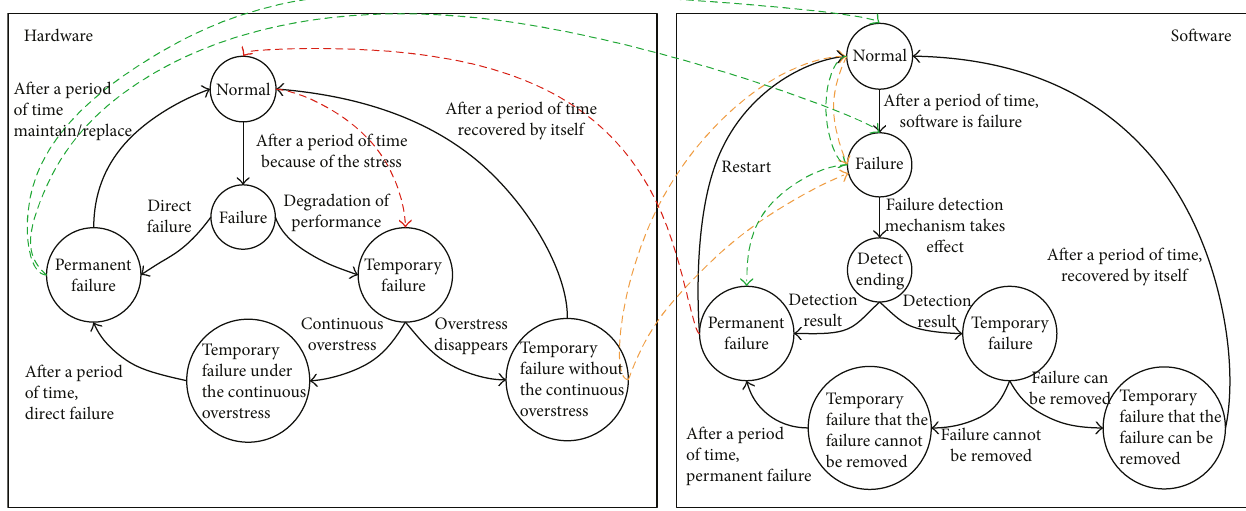
Figure 5: Interaction between software and hardware.